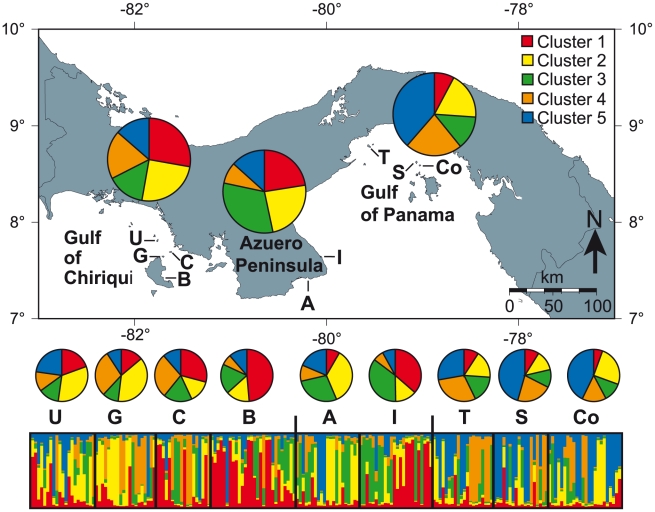
Map of Panama, showing the three main Pacific regions and the sampled locations.The pie charts show the distribution of the five genetic clusters identified by STRUCTURE 2.3 [141] in the three regional and nine reef populations. The bar plot shows each individual sample as a vertical bar with colors indicating the relative proportions of each genetic cluster. Map created on www.aquarius.ifm-geomar.de. U = Uva Island; C = Canal de Afuera Island; G = Granito de Oro Island; B  =  Bahia de Damas, Coiba Island; A  =  Achotines Bay; I  =  Iguana Island; S  =  Saboga Island; Co  =  Contadora Island; T  =  Taboga Island.